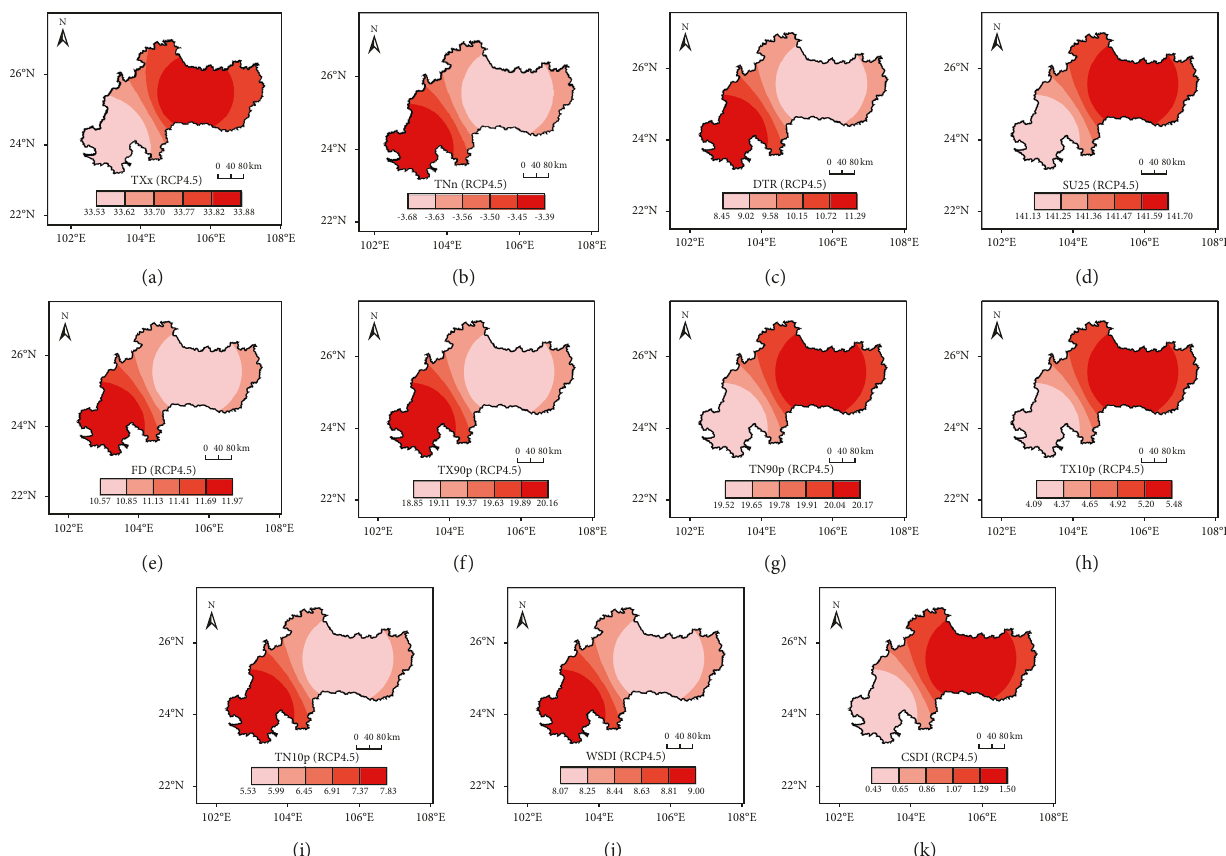
Figure 9: Spatial distribution of temperature extremes for 2021–2050 under